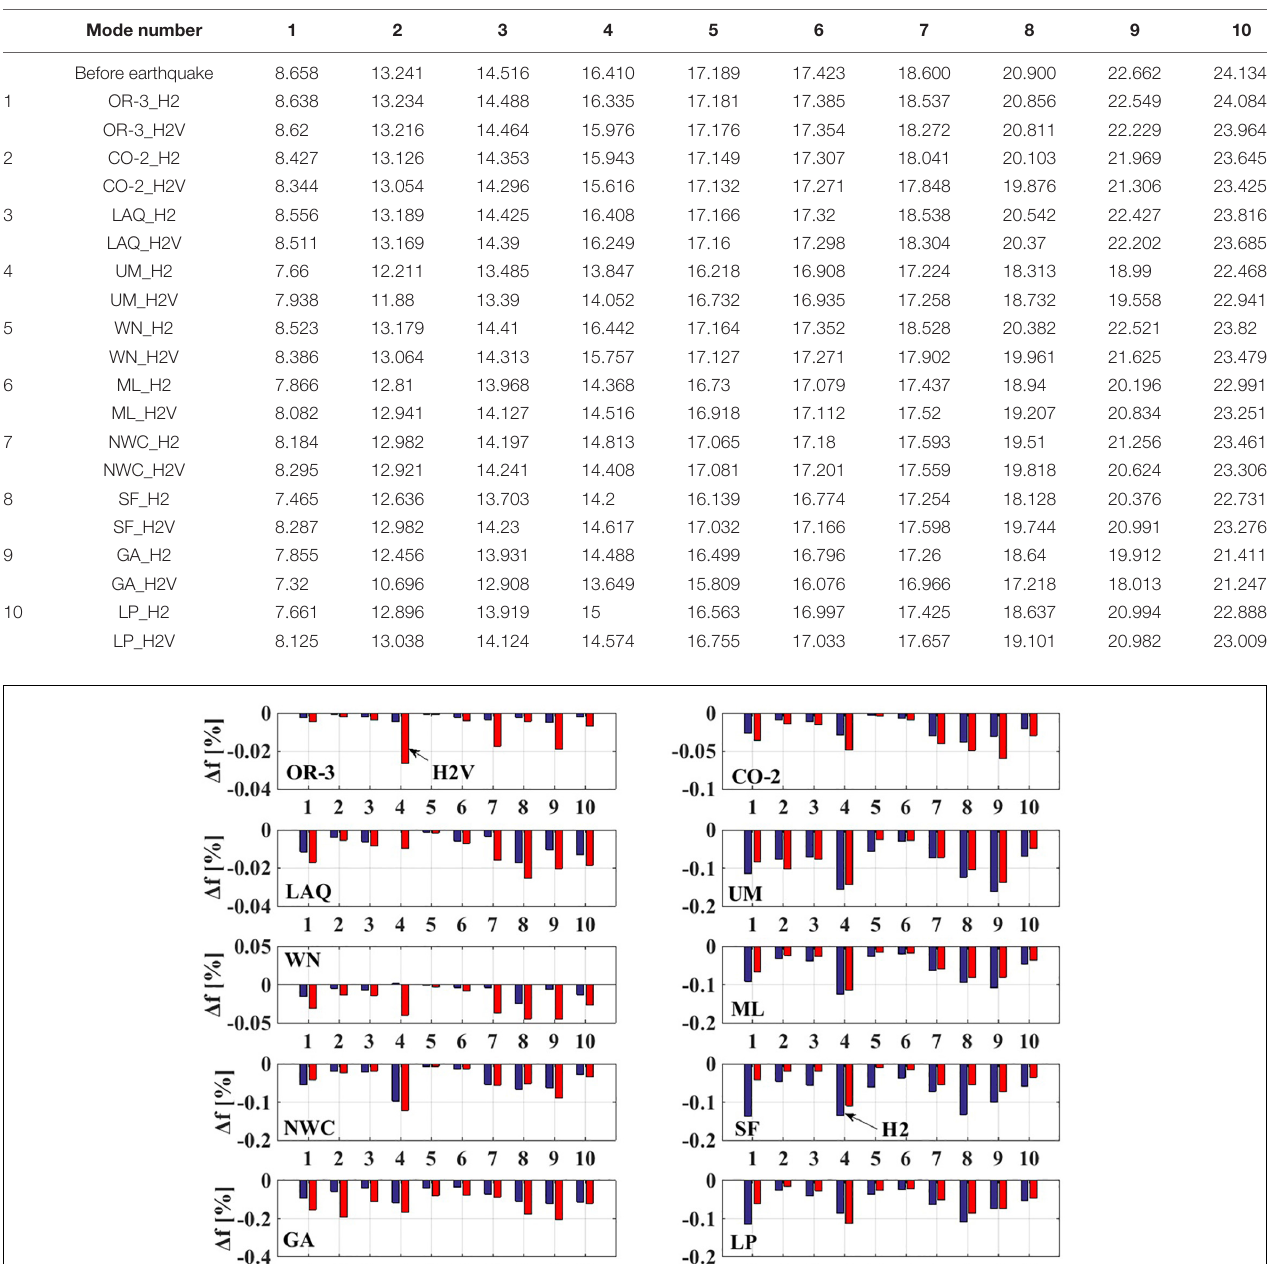
TABLE 3 | Eigenfrequencies after earthquake [Hz].